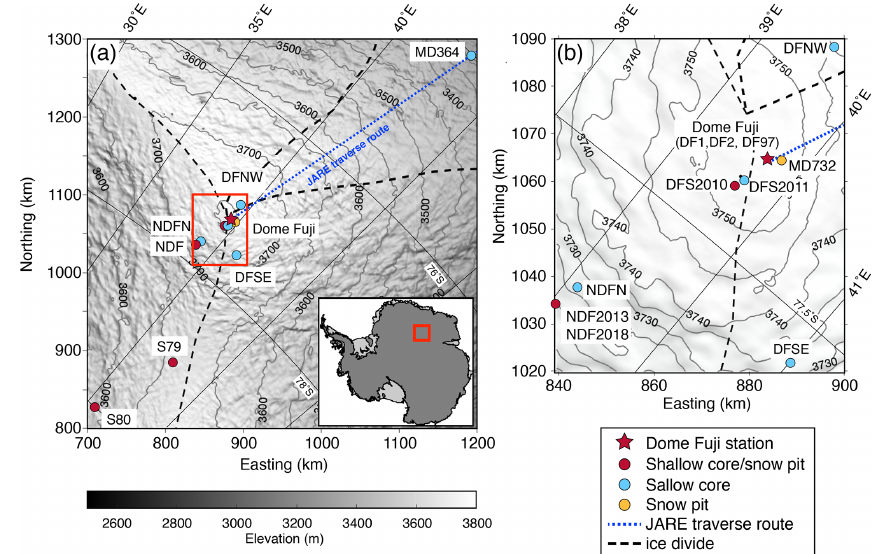
Figure 1. Locations of ice cores and snow pits (polar stereographic projection). (a) Overall view and (b) enlarged view. Markers in red are the sites with both an ice core and snow pit, markers in blue are ice core sites, and markers in yellow are snow pit sites. Surface elevation contour intervals are (a) 50m and (b) 5m (BedMachine, Morlighem et al., 2020). Figures were drawn using an open-source MATLAB toolbox (Antarctic Mapping Tools, Greene et al.,